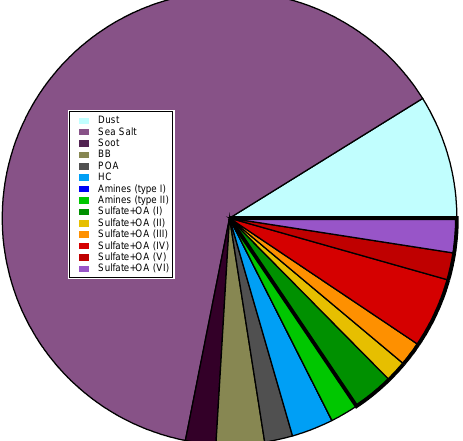
Figure 6. Fraction of total sampled number of supermicron parti- cles at T0, as identified by the SPLAT II instrument, over the period 17 June–25 June. It should be noted that the sea-salt particle type, which is the most abundant particle type observed, includes par- ticles with varying amounts of NaCl, NaNO 3 , and organics. The solid black outline groups the various Sulfate + OA particle types. (Amine Type I particles were not observed in sufficient abundance to be seen in the pie chart.)